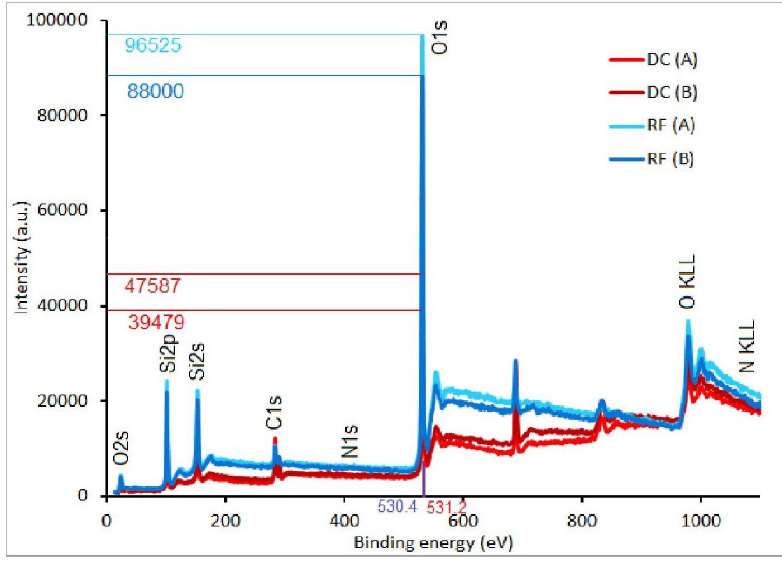
Figure 4. X-ray photoelectron spectroscopy (XPS) survey spectra of deposited films onto polytetrafluoroethylene (PTFE) substrates deposited by DC and RF plasma jets in conditions A and